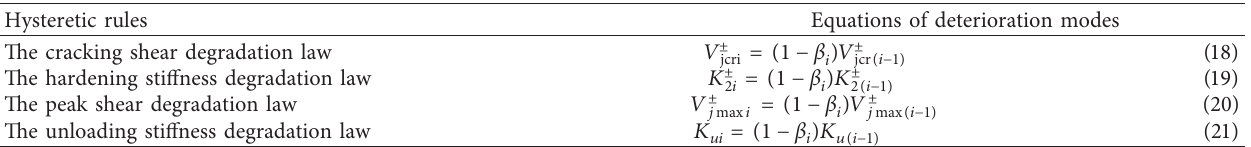
Figure 12: Individual deterioration modes, illustrated on a peak-oriented model: (a) basic strength deterioration. (b) Post-capping strength deterioration. (c) Unloading stiffness Table 9: The equations of individual cyclic deterioration laws.